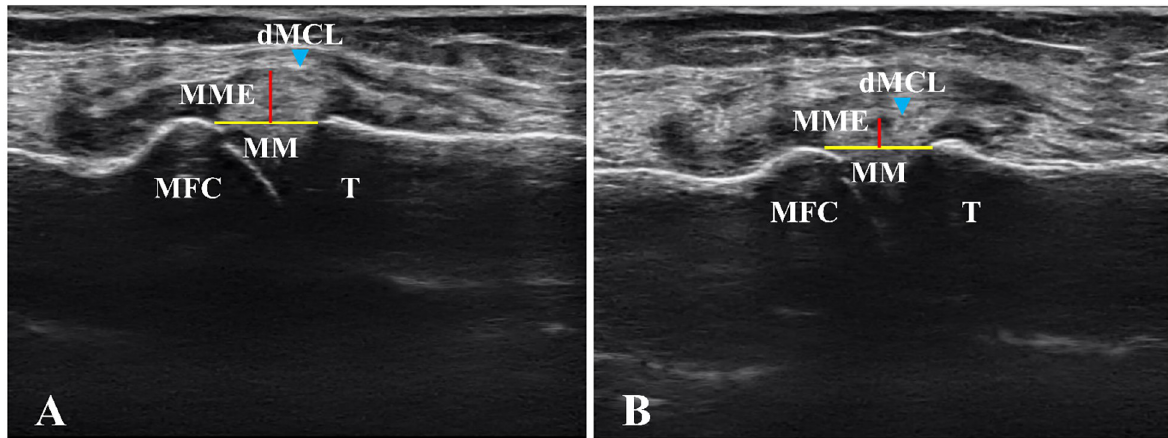
Fig 4. Images from a subject showing changes in MME at baseline (A) and 8 weeks (B). MME (red line) was lower at 8 weeks than at baseline. The dMCL (light blue arrowhead) was bulging at baseline and flattened at 8 weeks. Abbreviations: dMCL, deep posterior bundle of the medial collateral ligament; MM (yellow line), medial meniscus; MME; medial meniscus extrusion; MFC, medial femoral condyle; T,